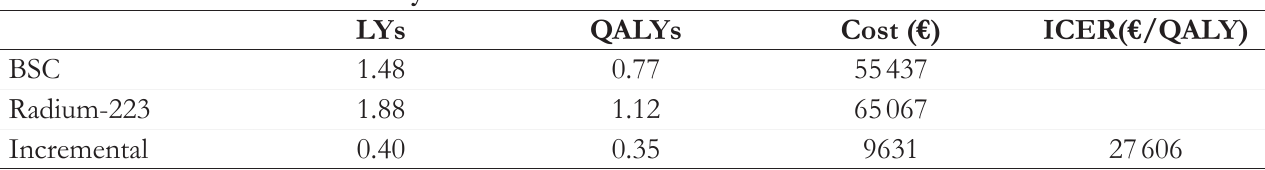
Table 4. Cost-effectiveness Analysis Base Case